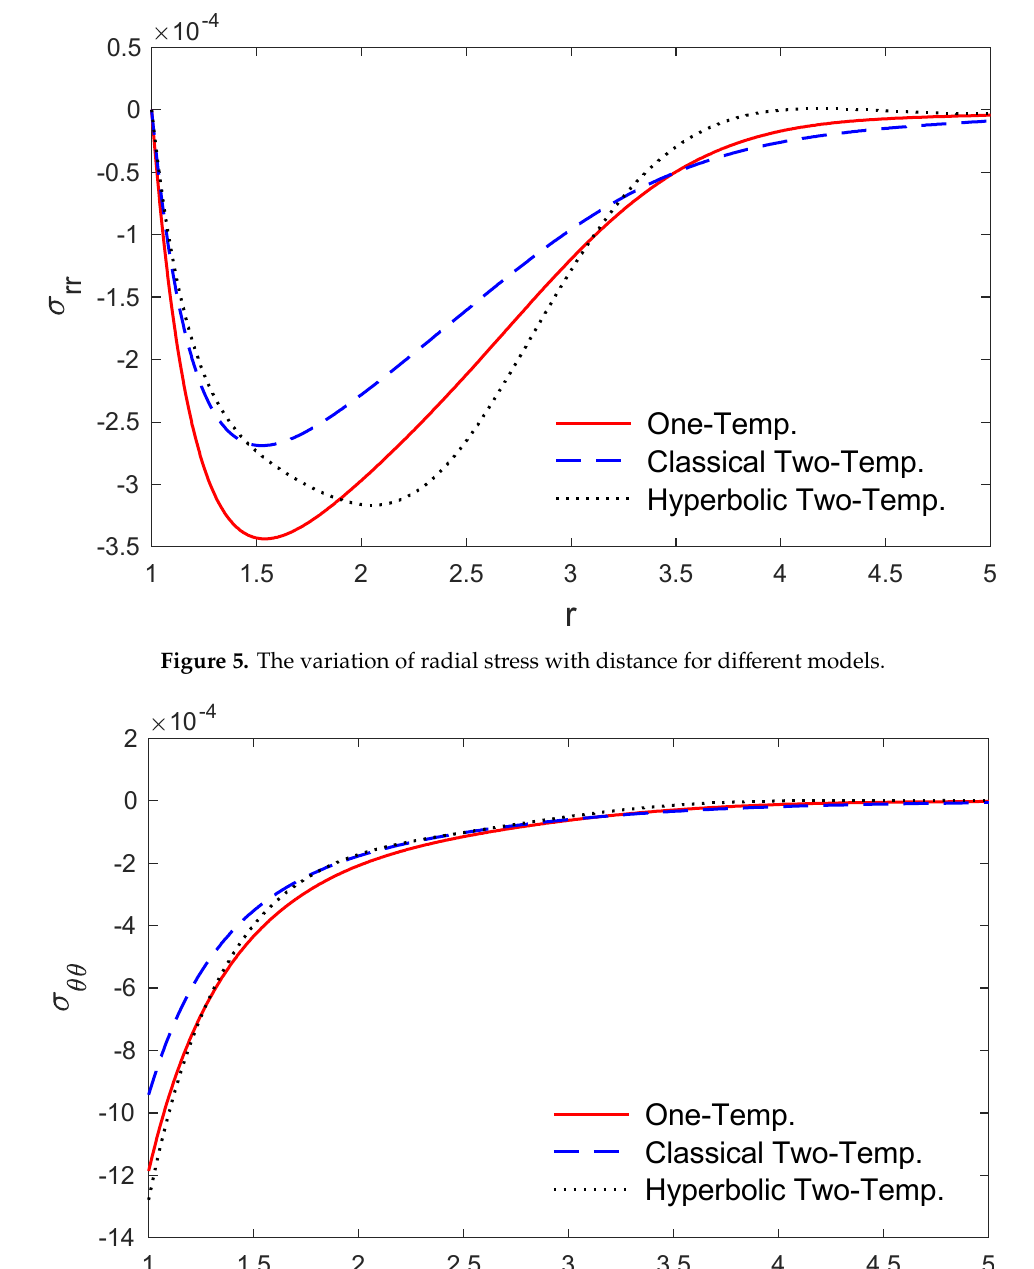
Figure 4. The variation of displacement with distance for different models.